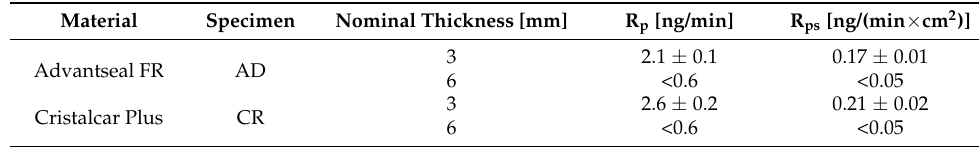
Table 3. Hydrogen permeability test average results.